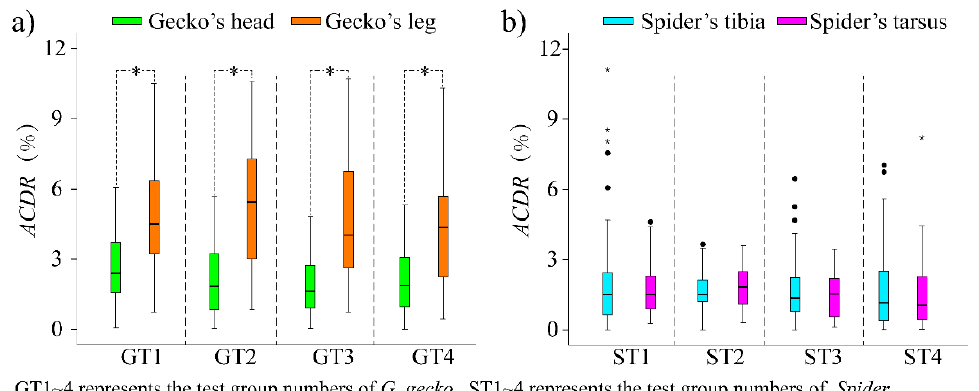
Figure 8. Statistical analysis of ACDR in Motion Capture of Gecko and Spider ( a ) Average deviation of gecko motion capture; ( b ) Average deviation of spider motion capture.